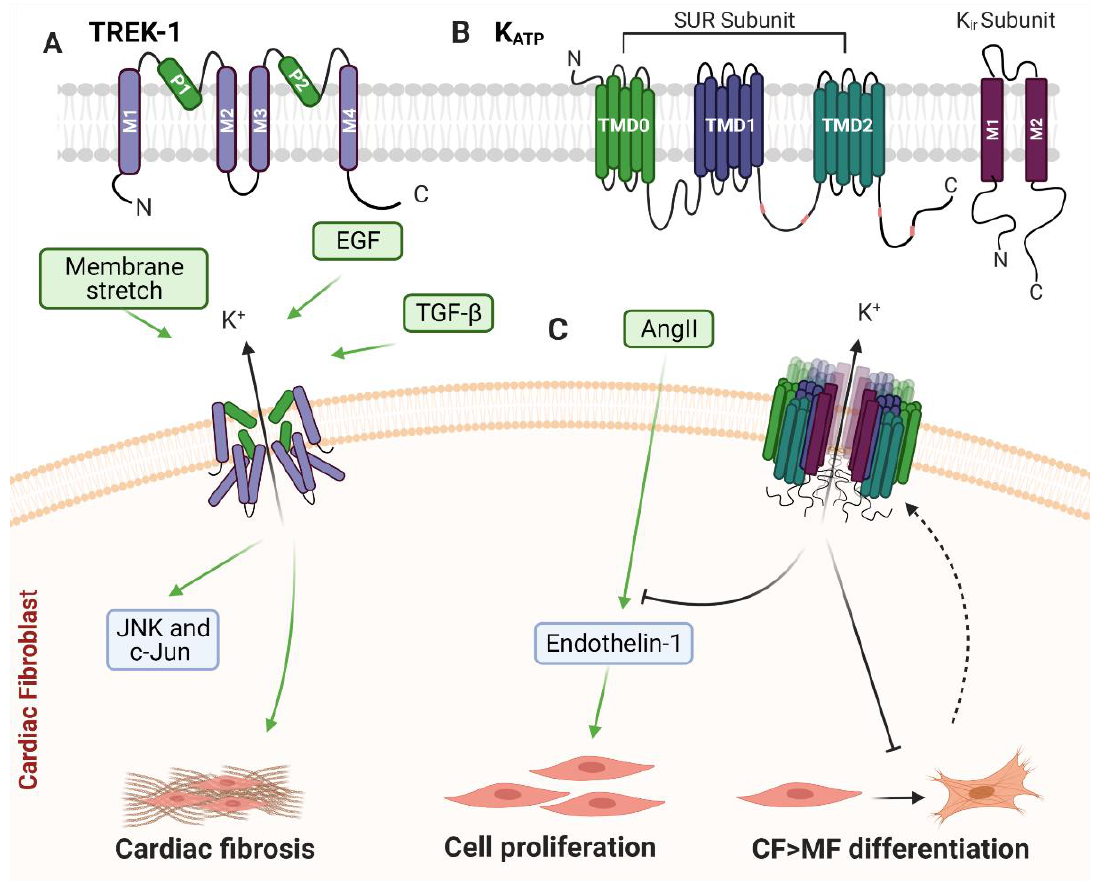
Figure 6. Schematic diagram of TREK-1 and K ATP structure and cardiac fibroblast signalling. ( A ) Predicted basic alpha subunit structure of TREK-1. TREK-1 subunits are composed of four transmembrane domains (M1-M4) and two pore forming P-loops (P1-P2). ( B ) Predicted basic alpha subunit structure of K ATP . Each K ATP alpha subunit consists of one ABC transporter subunit (SUR) and one inward rectifier K + channel (Kir) subunit ( C ) Known TREK-1 homodimeric ion channel and K ATP tetrameric ion channel signalling in cardiac fibroblasts. Cardiac fibroblast TREK-1 activation promotes cardiac fibrosis. Membrane stretch, TGF- β and EGF modulate JNK and c-Jun phosphorylation via a TREK-1-dependent mechanism. K ATP gene expression is upregulated during cardiac fibroblast to myofibroblast transdifferentiation. Once active, K ATP attenuates Ang II-induced proliferation and endothelin-1 expression, while also inhibiting myofibroblast differentiation. See main text for details.